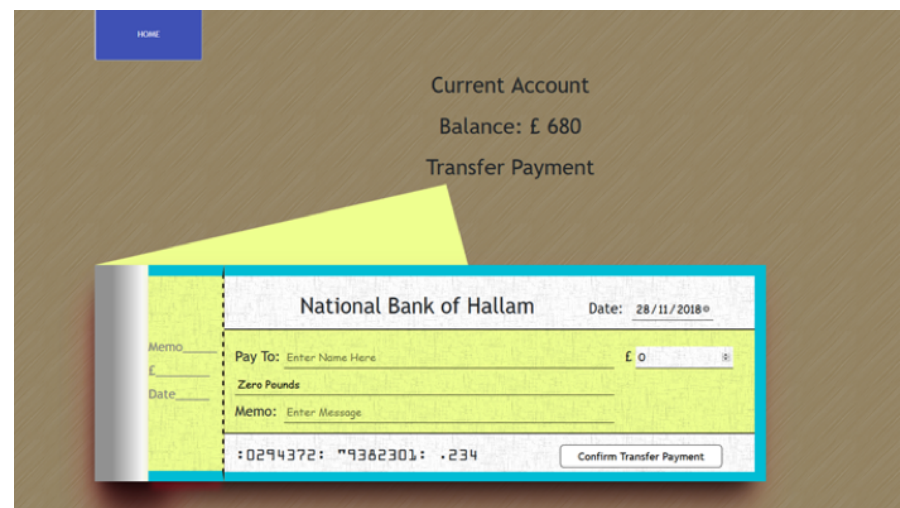
Figure 8. A screenshot of the money transfer page of our skeuomorphic